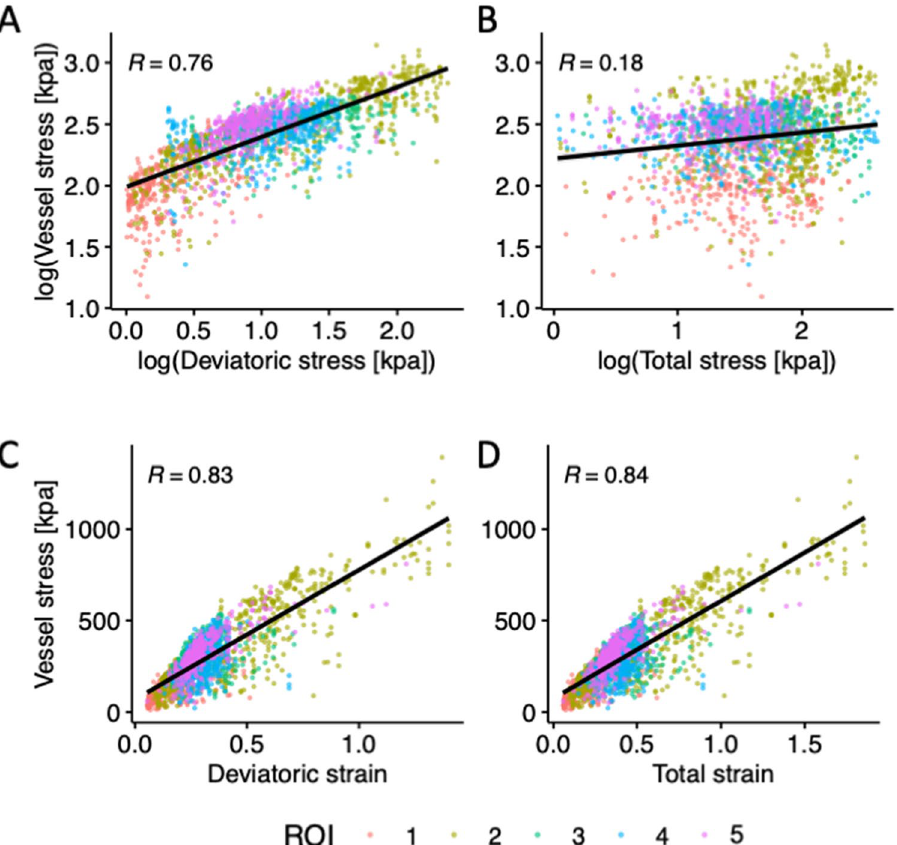
Figure 5. Correlation analysis for stress in vessels and ( A ) deviatoric stress, ( B ) total stress, ( C ) deviatoric strain and ( D ) total strain in the surrounding tissue. The data are predicted by the microscale models of vascular injury, developed for the five ipsilateral ROIs. Vessel stress refers to the tensile stress in vessels. Total stress and strain refer to the first principal stress and strain in the brain parenchyma and the deviatoric stress and strain refer to their deviatoric (shear)